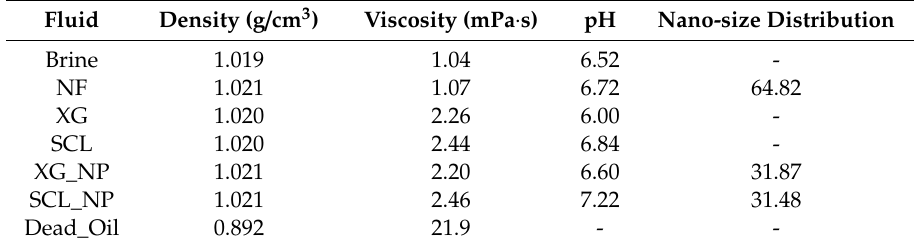
Table 3. Density, viscosity, pH and nano-size distribution results of the fluids used in this study.